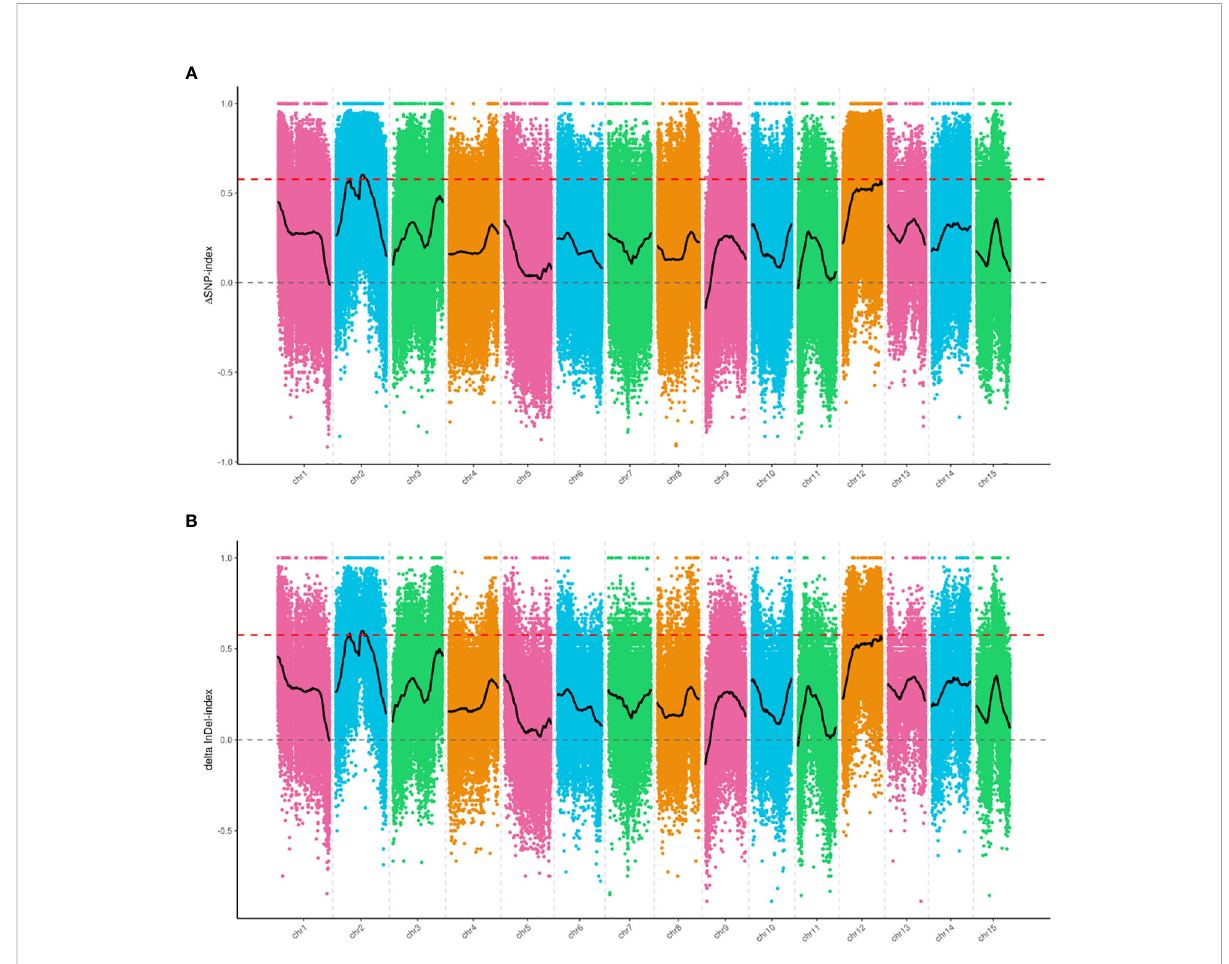
FIGURE 3 Candidate genomic regions for growth habit identi fi ed using (A) D (SNP-index) analysis and (B) D (InDel-index) analysis. The X -axis indicates the chromosome position, and the Y -axis indicates the D index values. The different colored points show the D index values calculated for speci fi c SNPs or InDels screened on different chromosomes. The black curves are the fi tted D index values. The red dashed lines represent the 99% threshold